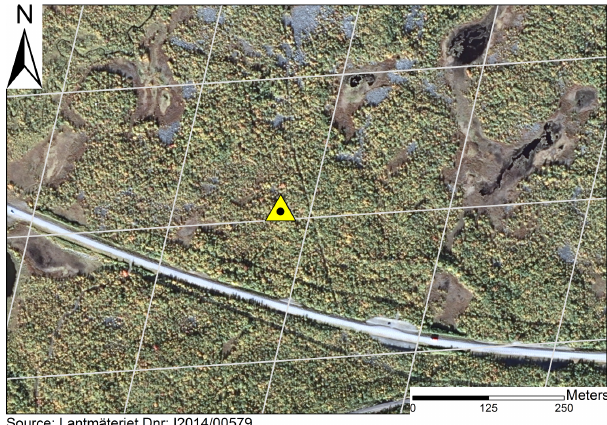
Figure 2. The location of the eddy covariance (EC) tower (yellow triangle) near the crossing point of four nominal MODIS pixels with 250 × 250m spatial resolution (white lines). Reference sys- tem: SWEREF99 TM. Lantmäteriet (Dnr: